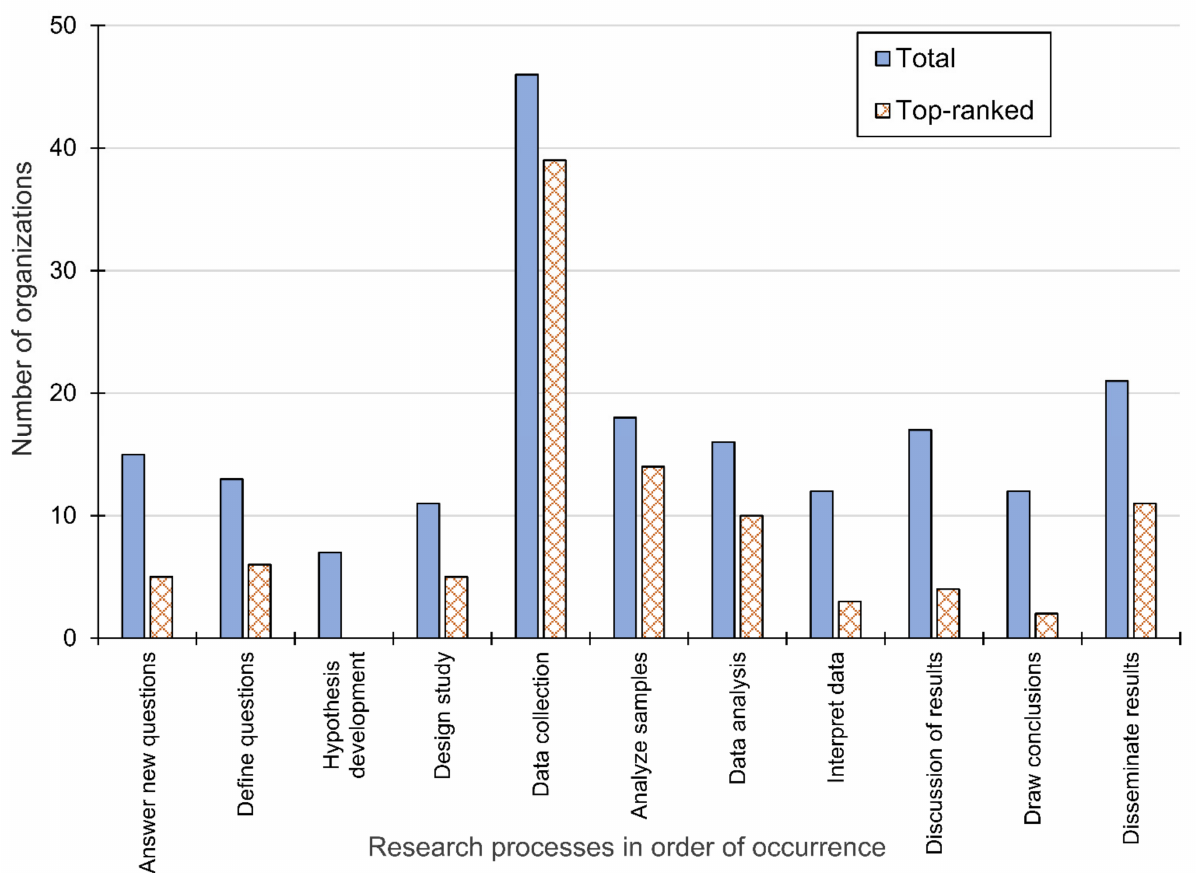
Figure 2. Research-related processes engaged in by members of the public. “Total” indicates if an organization involved members of the public in that process. “Top-ranked” indicates if the respondent from the organization ranked it as “most often” occurring. Each organization’s respondent could place up to two processes in the “top-ranked”